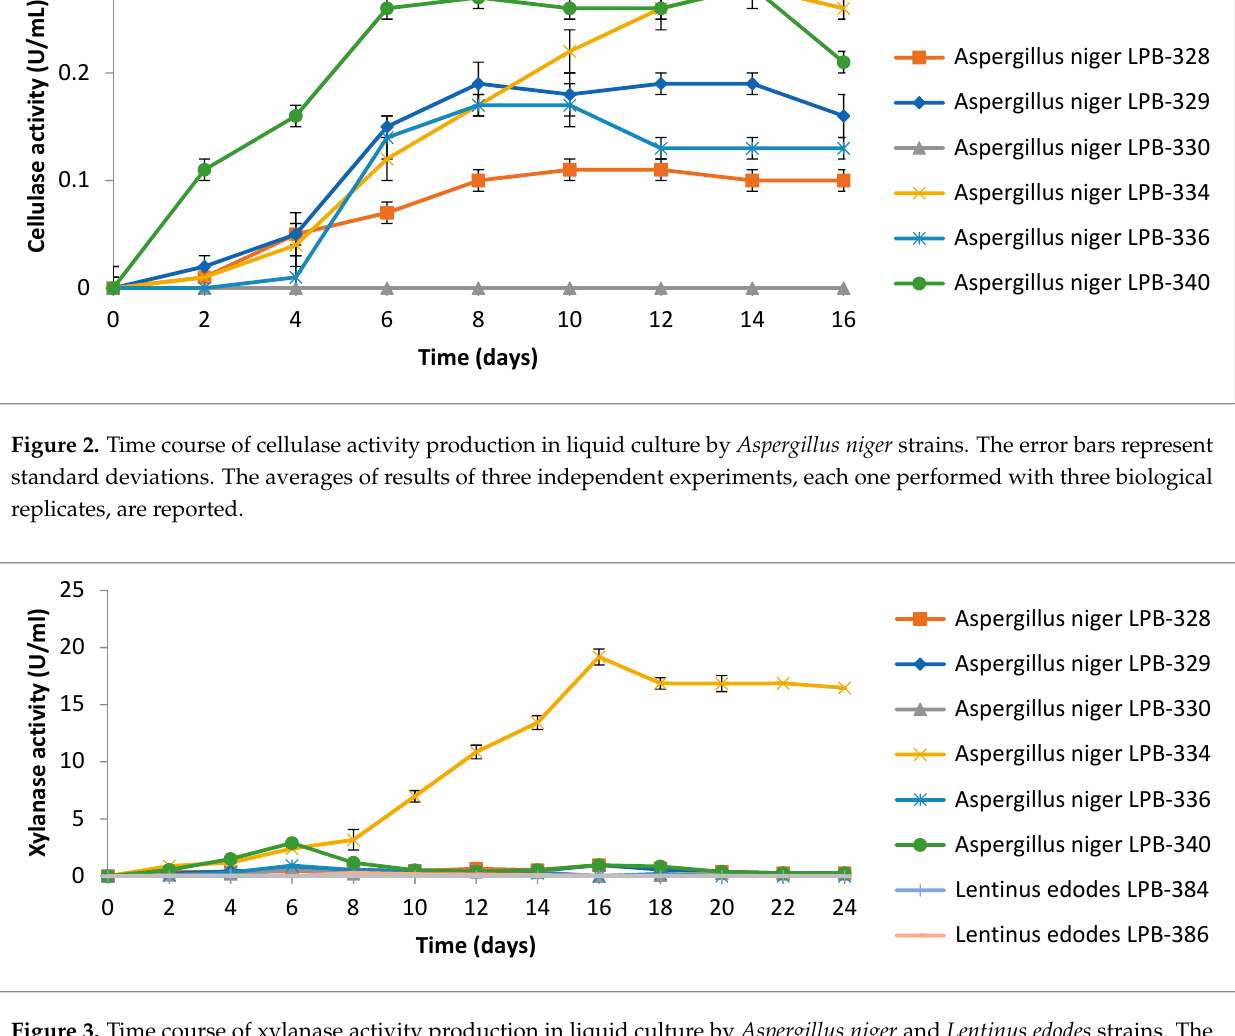
Figure 3. Time course of xylanase activity production in liquid culture by Aspergillus niger and Lentinus edodes strains. The error bars represent standard deviations. The averages of results of three independent experiments, each one performed with three biological replicates, are